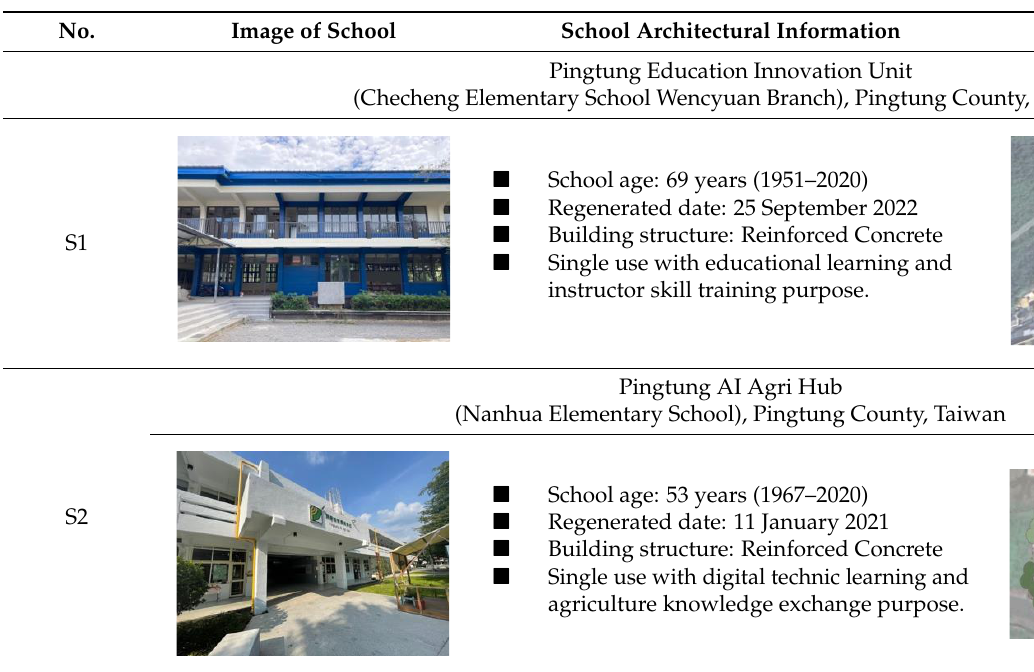
Table 1. Description of Redesign School Architecture.